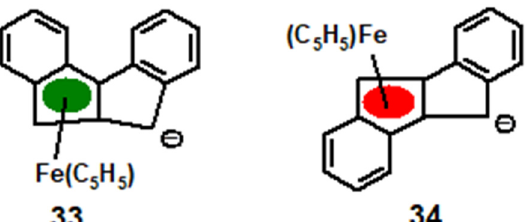
Figure 7. ( Left ) Potential energy hypersurface for the migration of an [Fe(C 5 H 5 )] + fragment over the dianion of the anti -dibenzpentalene framework, 34 . Contour lines are incremented in units of 5 kcal mol − 1 , and the favoured reaction path is superimposed as a dotted line. ( Right ) As above, for the syn -dibenzpentalene system, 33